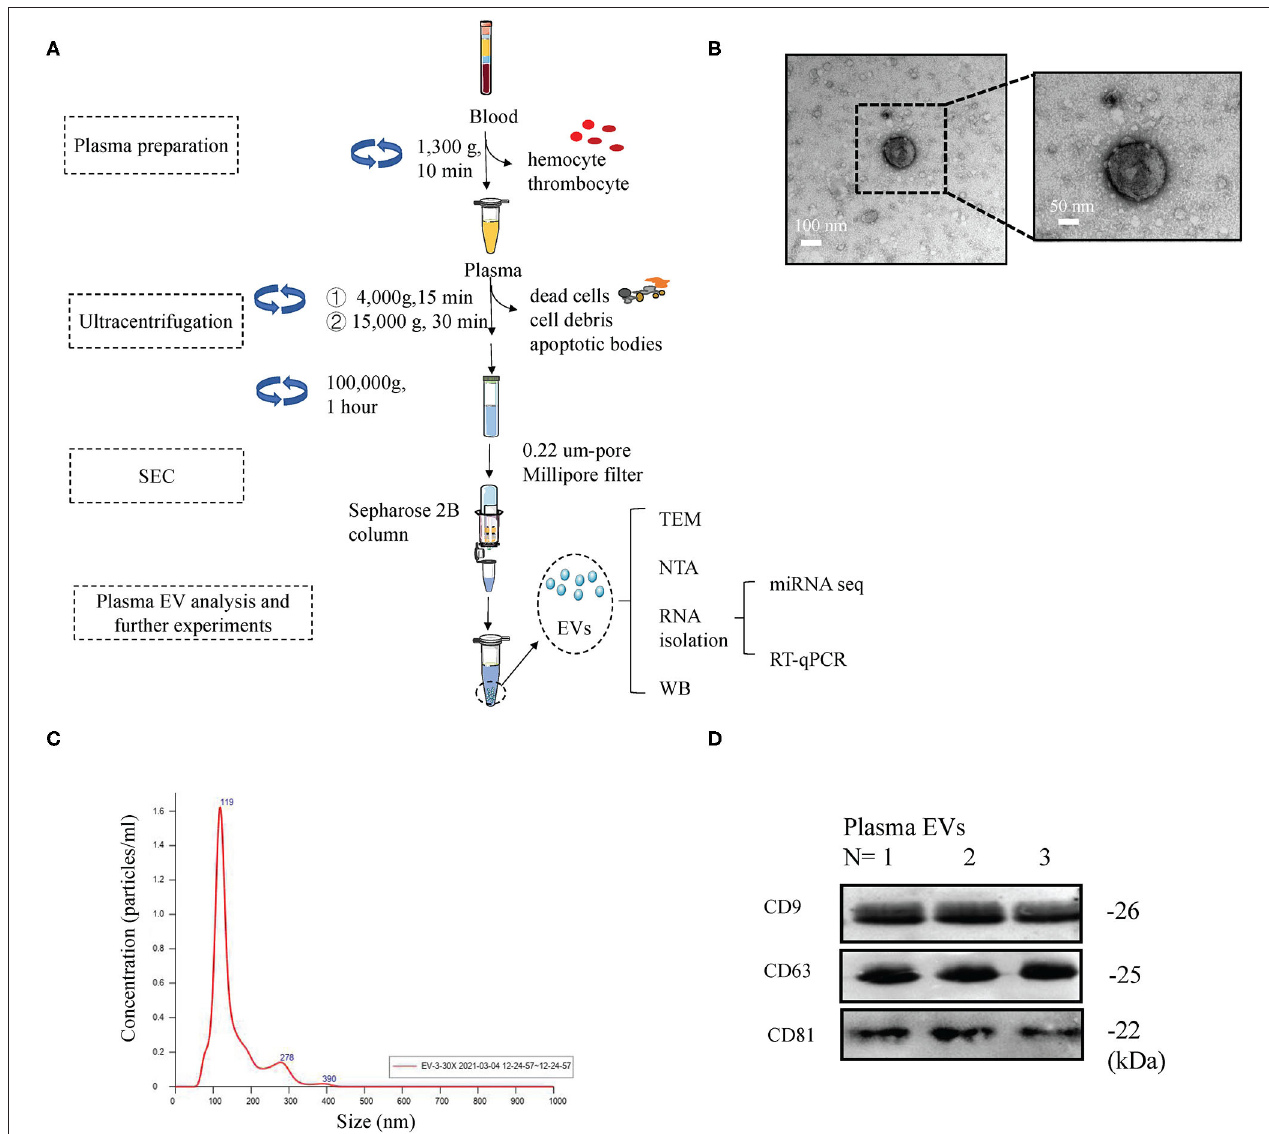
FIGURE 2 | Characterization of plasma EVs in obesity. (A) Procedure of EVs isolation from plasma. After collecting plasma samples, EVs were isolated using ultracentrifugation, followed by size-exclusion chromatography. (B) Transmission electron microscopy images of plasma EVs from obese patients; Scale bars = 100nm and 50nm. (C) Nanoparticle tracking analysis showing the concentration and size of plasma EVs from obese patients. (D) Western blotting results demonstrated the expression of EVs markers (CD9, CD63, and CD81) in plasma EVs in obese patients. EVs, extracellular vesicles; SEC, size-exclusion chromatography; TEM, transmission electron microscopy; WB, Western blotting; NTA, nanoparticle tracking